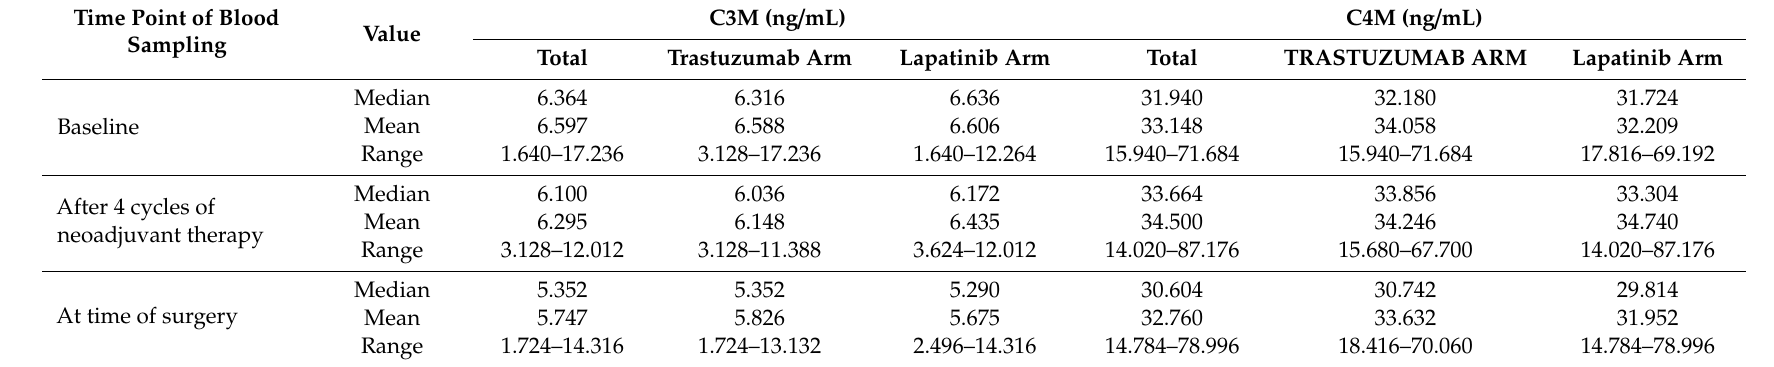
Table 2. Levels of C3M and C4M in the serum at di ff erent time points.